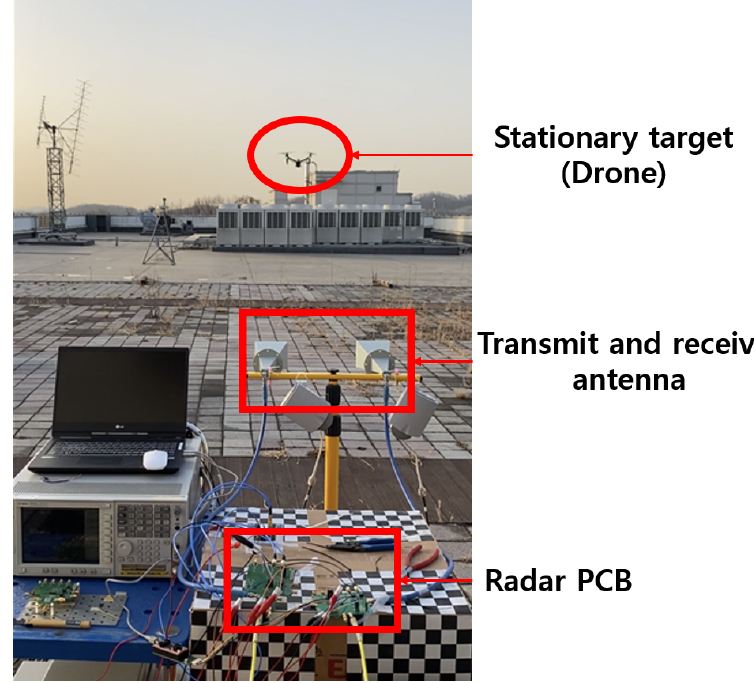
Figure 48. Pulse mode radar test